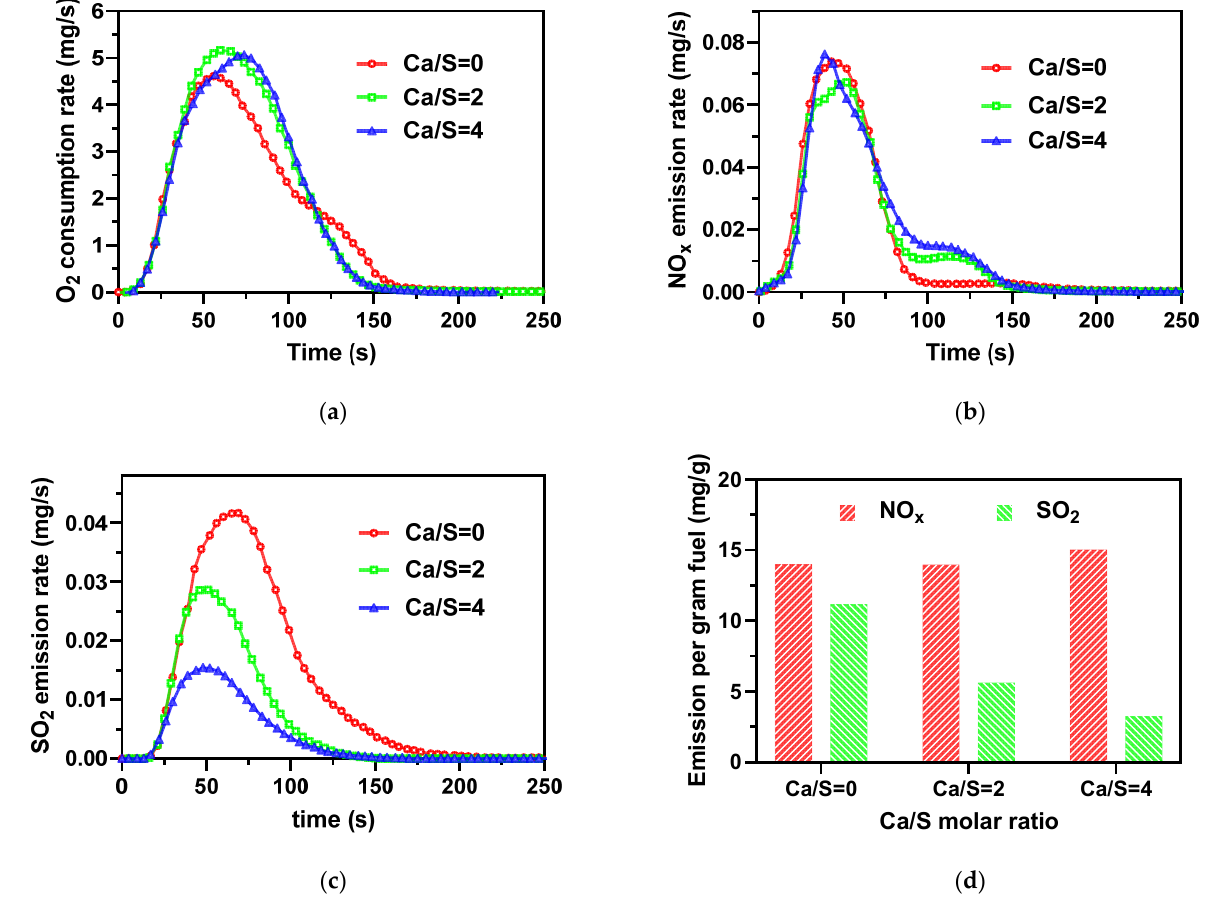
Figure 6. ( a ) O 2 consumption, ( b ) NO x emission, ( c ) SO 2 emission as a function of time during combustion of the AMR, and ( d ) NO x and SO 2 emissions per gram AMR at different molar Ca/S ratios. NO x emission and t max were similar for the different Ca/S molar ratios, as presented